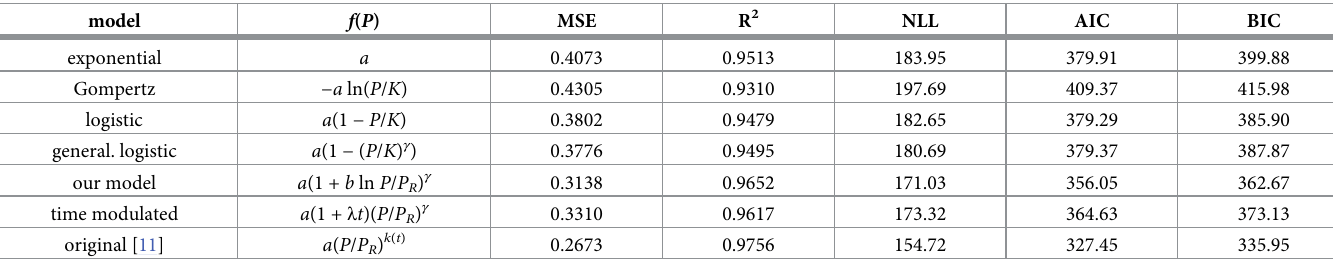
Table 2. Models used for fitting and respective per capita growth rates vs statistical and information criteria describing quality of the fit. model f ( P ) MSE R 2 NLL BIC exponential a Gompertz logistic general. logistic our model a (1 + b ln P / P R ) γ time